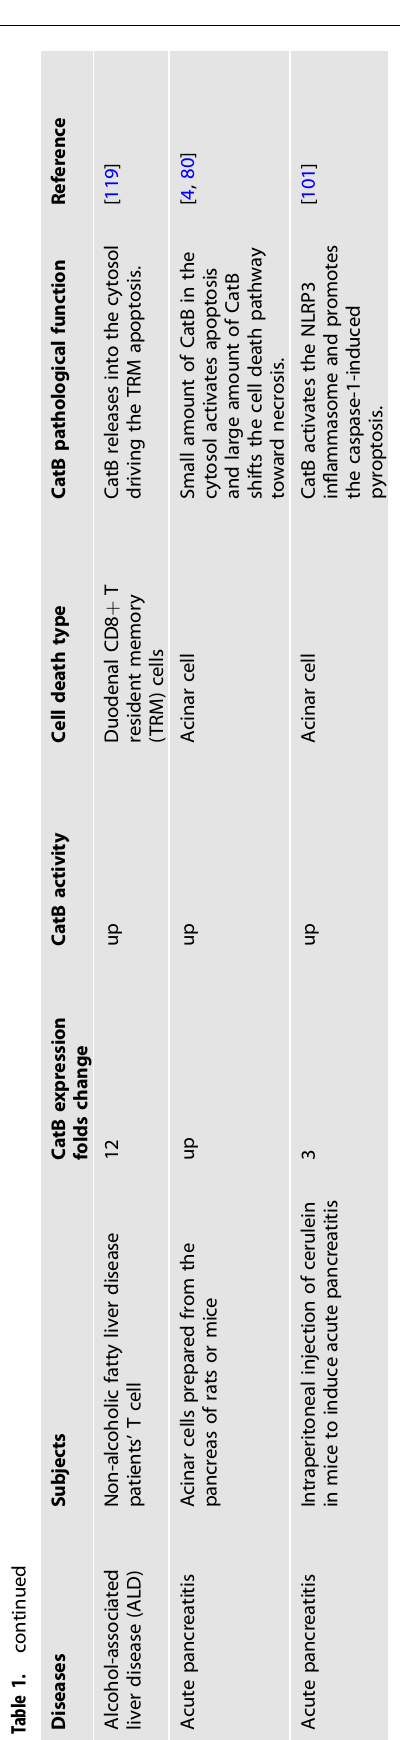
Cell Death and Disease (2023)